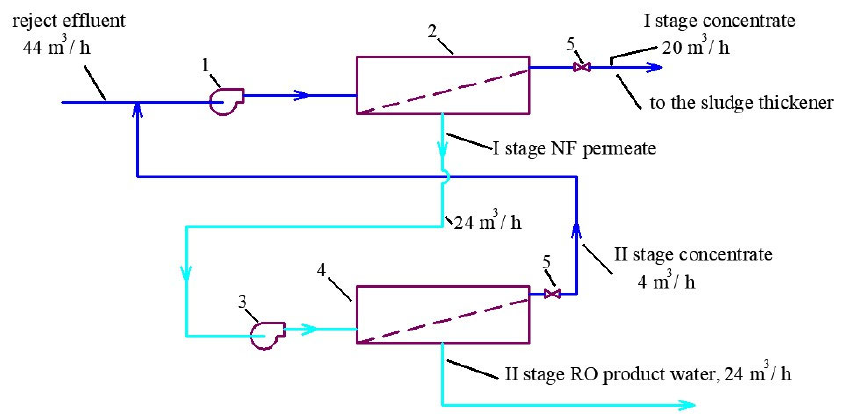
Figure 4. A flow diagram of the double-stage membrane facility to treat mineralized effluent after sludge dewatering: 1—working pump for the first-stage membranes (nanofiltration); 2—nanofiltration membrane module; 3—working pump for the second-stage reverse osmosis membranes; 4—reverse osmosis membrane modules; 5—pressure regulation valve.